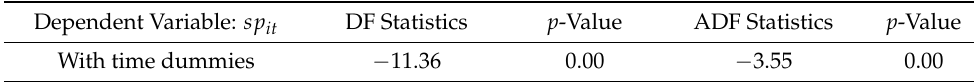
Table 7. Kao (1999) Residual-based cointegration test. Dependent Variable: sp it With time